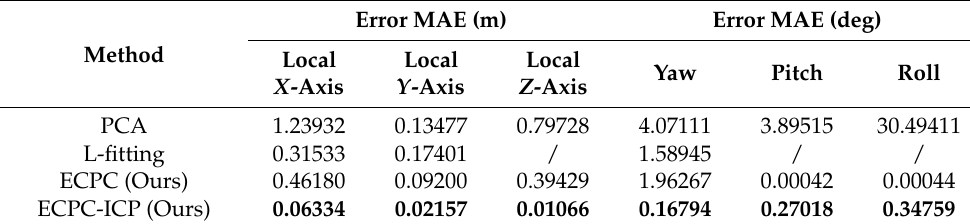
Table 1. MAE of different methods in all